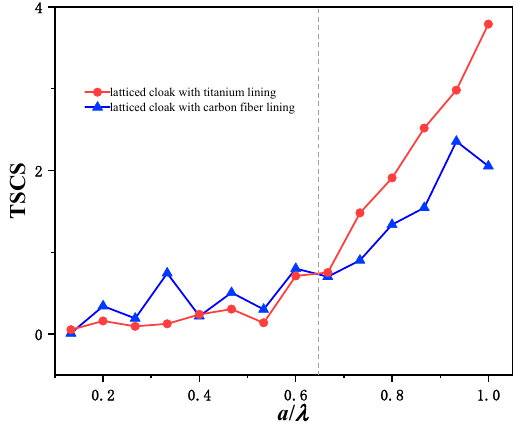
Figure 18. TSCS spectra of PM acoustic cloak with carbon fiber lining.